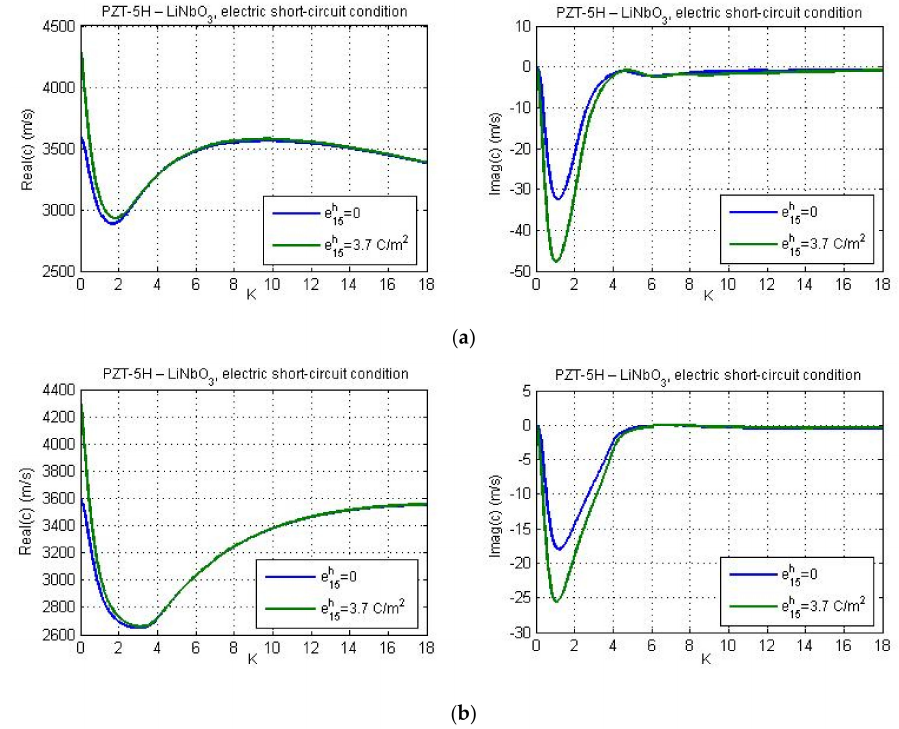
Figure 11. The dispersion curves for the material combination PZT-5H—LiNbO 3 with and without considering the effect of piezoelectric properties of the substrate under electric short-circuit conditions and for guiding layer thickness: ( a ) h = 20 nm and ( b ) h = 40 nm.